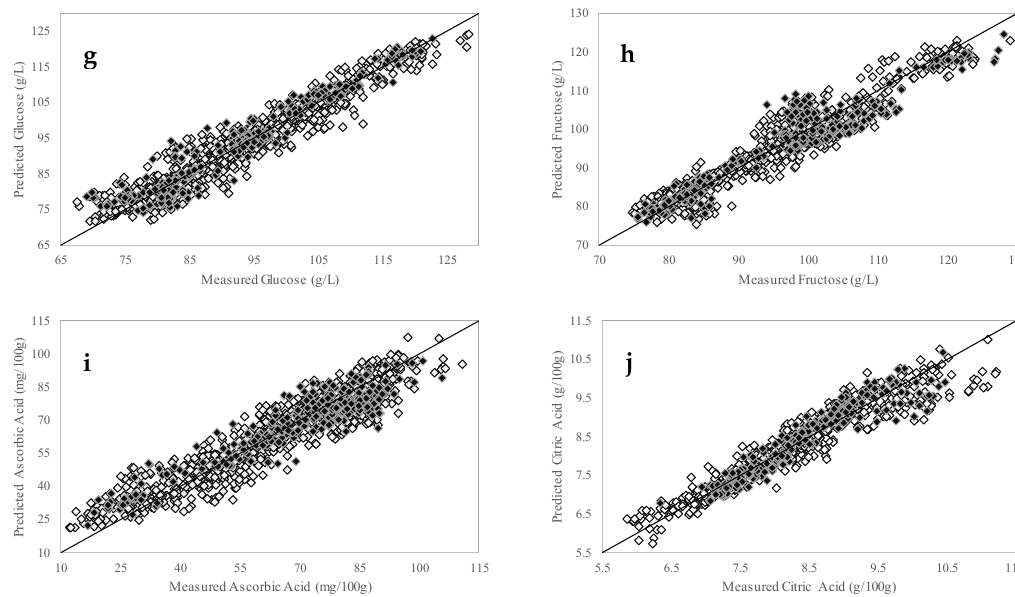
Figure 3. PLSR correlation plots for different quality traits in tomato paste using portable FT-IR unit equipped with a triple-reflectance ATR accessory (white and black diamonds represent calibration and validation set samples, respectively) ( a ) natural tomato soluble solids, ( b ) pH, ( c ) Bostwick consistency, ( d ) titratable acidity, ( e ) serum viscosity, ( f ) lycopene, ( g ) glucose, ( h ) fructose, ( i ) ascorbic acid, ( j ) citric acid.